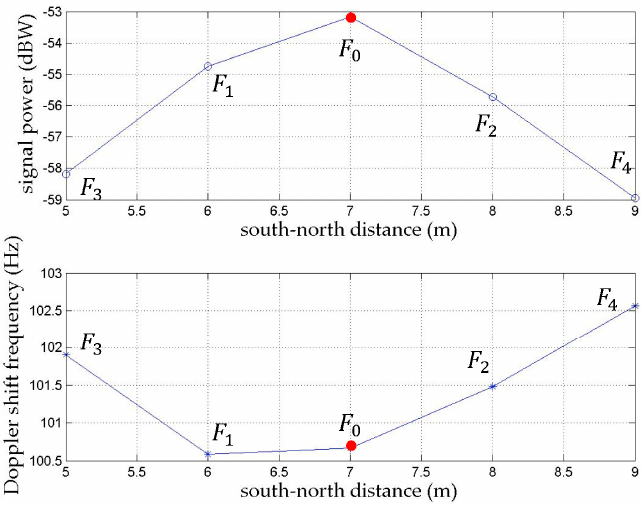
Figure 11. Comparison of Doppler shift frequency and signal power for dominant facet F 0 and four adjacent facets. The power level of the adjacent facets decline rapidly so that the received power at the radar is dominated by the facet F 0